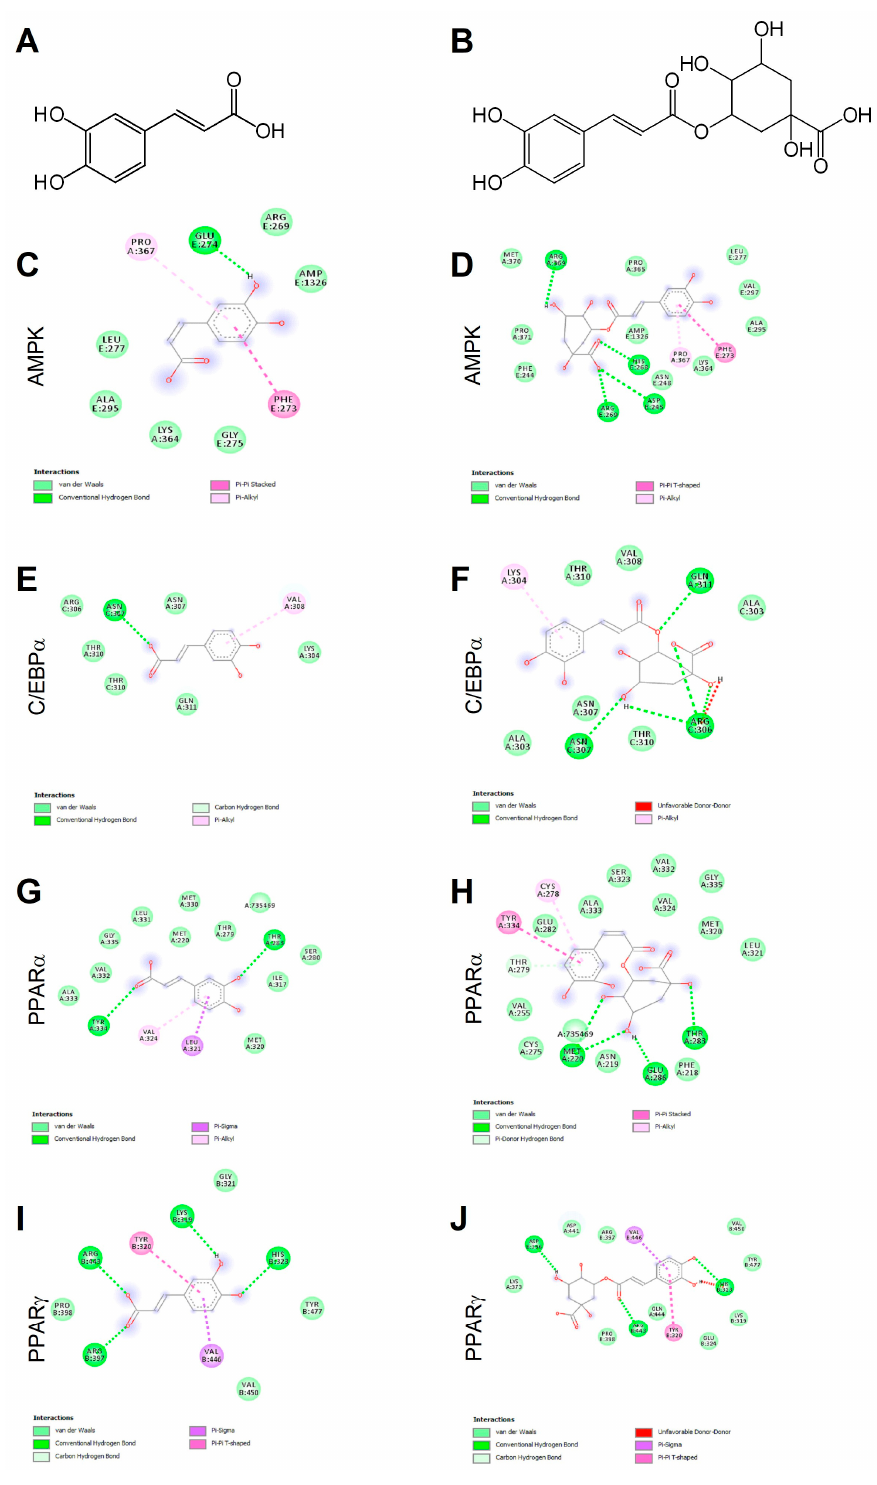
Figure 1. Chemical structures of ca ff eic and chlorogenic acids and molecular docking models of putative interactions with target proteins. Ca ff eic acid chemical name: (E)-3-(3,4- dihydroxyphenyl)prop-2-enoic acid; Mw 180.16 g / M ( A ). Chlorogenic acid chemical name: (1S,3R,4R,5R)-3-[(E)-3-(3,4-dihydroxyphenyl) prop-2-enoyl]oxy-1,4,5-trihydroxycyclohexane-1-carboxylic acid; Mw 354.31 g / M ( B ). Putative interaction between ca ff eic acid and AMP-activated protein kinase (AMPK; PDB: 4CFF); Free energy of binding ( ∆ G) and a ffi nity (Ki) are − 6.4 kcal / M and 20.6 µ M, respectively ( C ). Chlorogenic acid and AMPK (PDB: 4CFF); ∆ G − 8.1 kcal / M; Ki 1.2 µ M ( D ). Ca ff eic acid and CAAT / enhancer-binding protein alpha (C / EBP α ; PDB: 1NWQ); ∆ G − 4.7 kcal / M; Ki 362.5 µ M ( E ). Chlorogenic acid and C / EBP α (PDB: